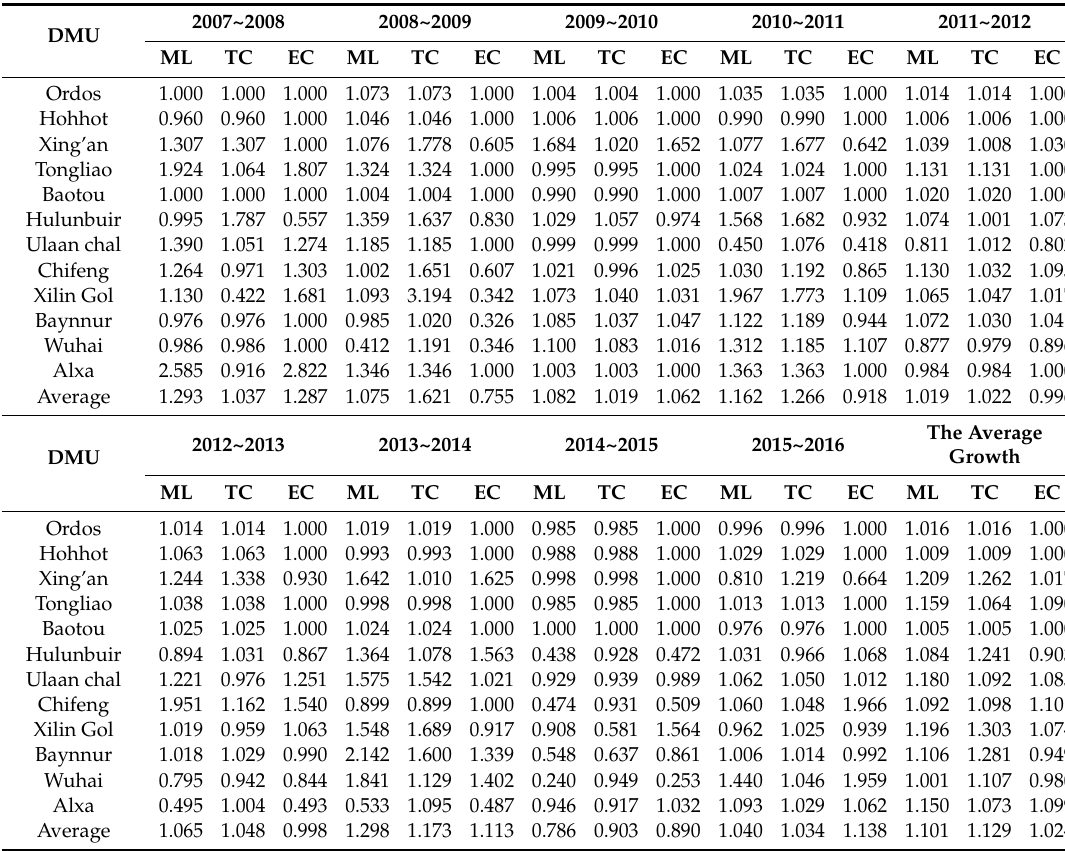
Table 4. The values of the Malmquist–Luenberger (ML) index, technical progress change (TC) and e ffi ciency change (EC) in Inner Mongolia cities from 2007 to 2016. (DMU = decision-making